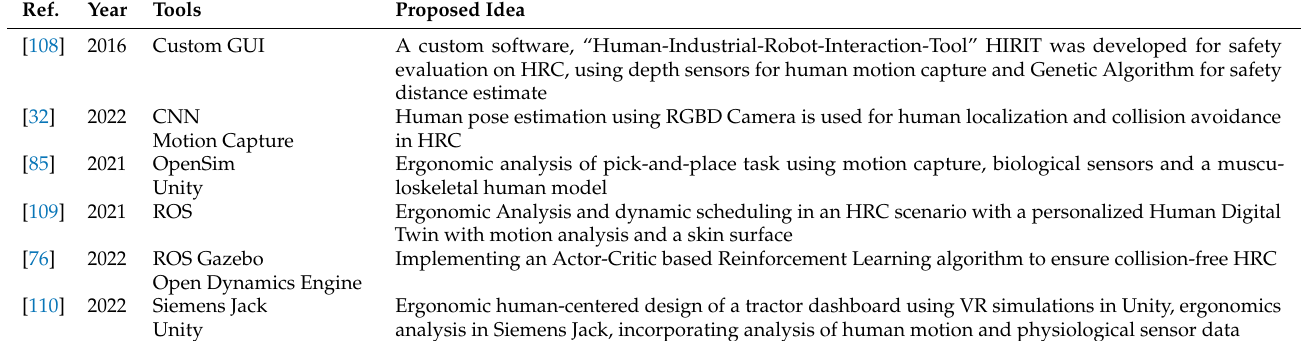
Table 4. Applications in Ergonomics and